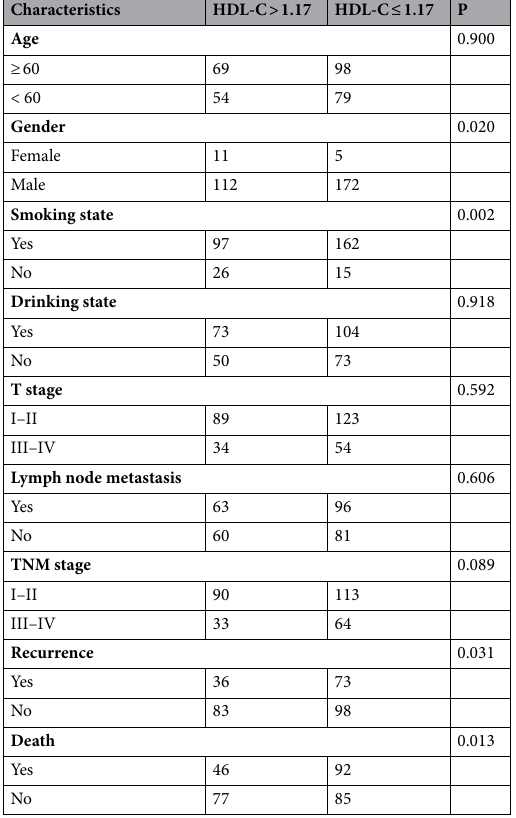
Table 4. Relationship between HDL-C concentration and clinical characteristics in 300 Patients With squamous cell carcinoma of lung based on chi-square